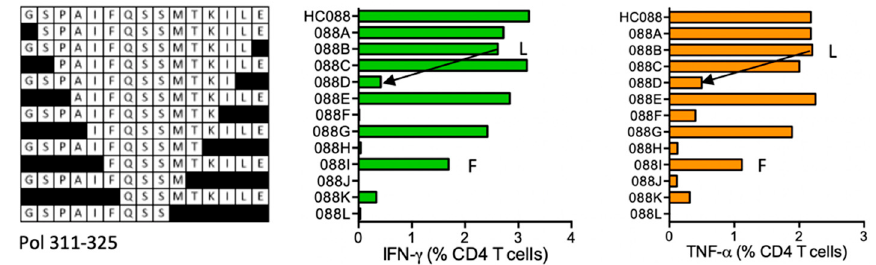
Figure 8. HC088/VID 411—definition of CD4 + T-cell epitopes in HIV-1 protein Pol. HC088 STCL of subject 411 was tested in an ICS assay against serially truncated peptides for induction IFN- γ (green) and TNF- α (orange) by CD4 + T cells. Arrows and amino acids F and L indicate the stimulatory peptide termini.